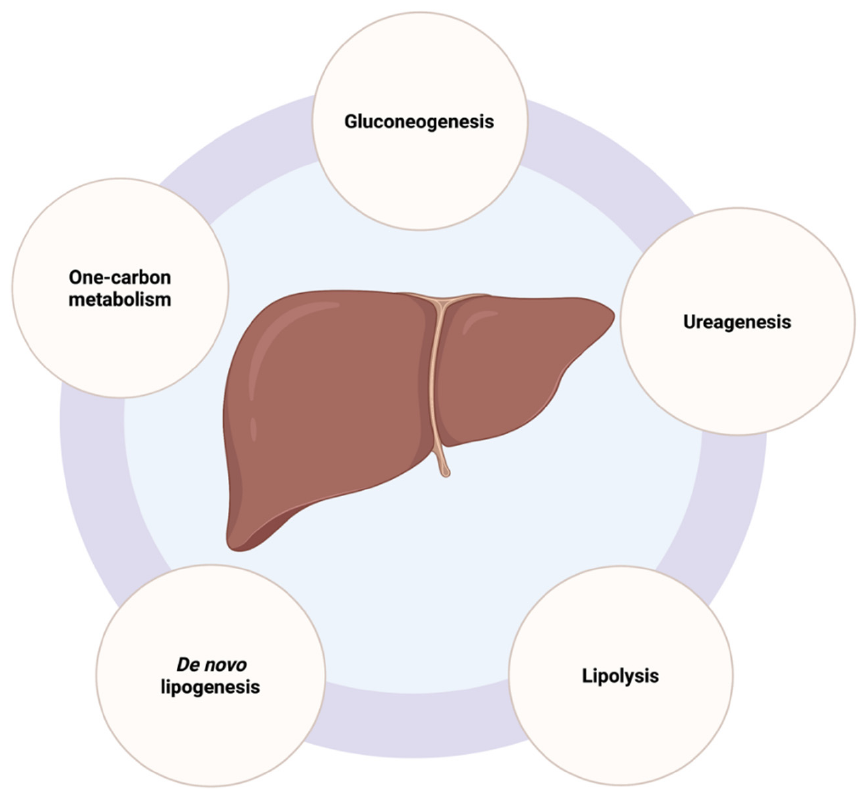
Figure 2. Schematic representation of the main hepatic metabolic functions in which mitochondria have a critical role. Created with Biorender.com (accessed on 21 February 2022; Toronto, ON, have a critical role. Created with Biorender.com (Toronto, ON, Canada).